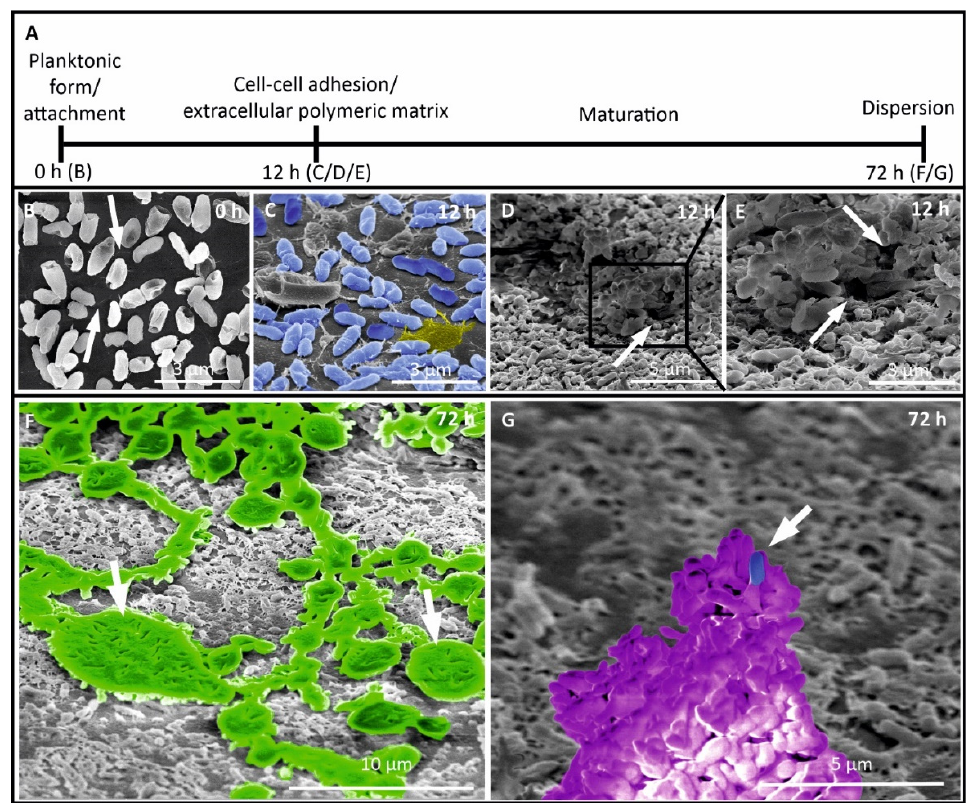
Figure 3. Scanning electron microscopy (SEM) of biofilm production by Pseudomonas aeruginosa . ( A ) Schematic representation of biofilm development on surfaces. ( B ) Planktonic form of Pseudomonas aeruginosa with pili in place (arrow heads). ( C ) Attached microorganisms on the surface start to grow and cells adhere to the surface (for better visualization, the bacteria are colored in blue), secretion of the exopolysaccharide matrix is starting (a small EPS area as an example is colored in yellow). ( D , E ) Bacteria start to form microcolonies with specific coaggregation between them, maturation of the biofilm is characterized by three-dimensional forms such as columns, towers, and channels (arrow heads). ( F ) Ongoing maturation phase shown by firm slime production (arrow heads and colored in green). ( G ) Last phase of biofilm formation, a mushroom-like body (colored in purple) and dispersion of single bacteria (one example is colored in blue) are